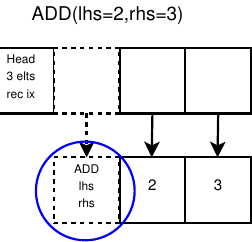
Figure 2: Adding record information to the data struc- ture to simplify the work of the debugger at a small memory overhead (marked with a circle).